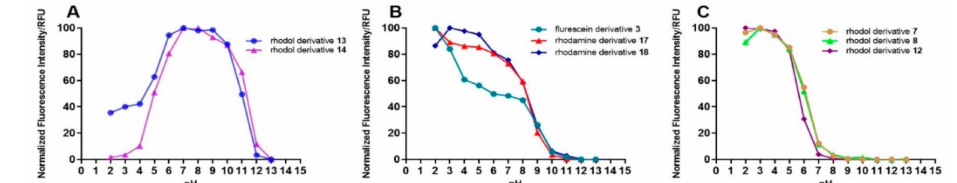
Figure 4. pH-Dependent fluorescence spectra of asymmetric and reduced xanthene fluorophores (Normalized fluorescence intensity plotted against pH at 1.0 µ M) in bu ff ers with pH ranging from 2 to 13. ( A ) rhodol 13 ( λ ex / λ em = 472 / 532 nm) and rhodol 14 ( λ ex / λ em = 510 / 553 nm); ( B ) fluorescein 3 ( λ ex / λ em = 456 / 518 nm), rhodamine 17 ( λ ex / λ em = 490 / 537 nm) and rhodamine 18 ( λ ex / λ em = 504 / 556 nm); ( C ) rhodol 7 ( λ ex / λ em = 473 / 535 nm), rhodol 8 ( λ ex / λ em = 490 / 554 nm) and rhodol 12 ( λ ex / λ em = 467 /